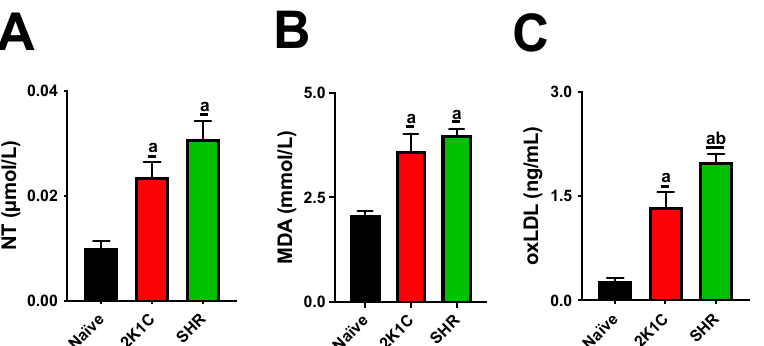
Figure 1. Oxidative/nitrosative stress markers in normotensive and hypertensive high ‐ fat ‐ fed rats. Serum nitrotyrosine ( A ), malondialdehyde ( B ), and oxidized low ‐ density lipoprotein levels ( C ) are presented. The data are expressed as mean ± standard error of the mean. a p ≤ 0.05 when compared with naive; b p ≤ 0.05 when compared with 2K1C group. 2K1C: two ‐ kidney ‐ one ‐ clip hypertension; MDA: malondialdehyde; NT: nitrotyrosine; oxLDL: oxidized low ‐ density lipoprotein; SHR: spontaneously hypertensive rats.